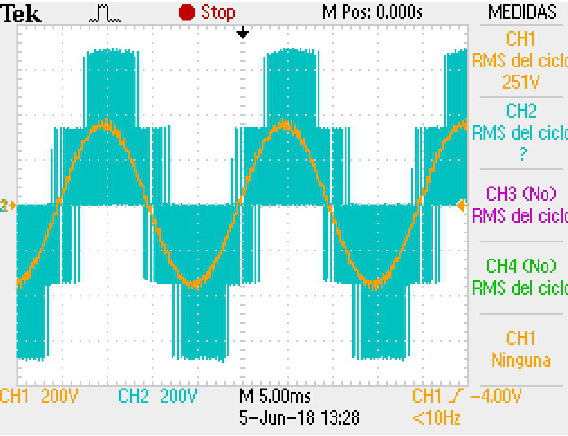
Figure 22. PWM and voltage from phase a